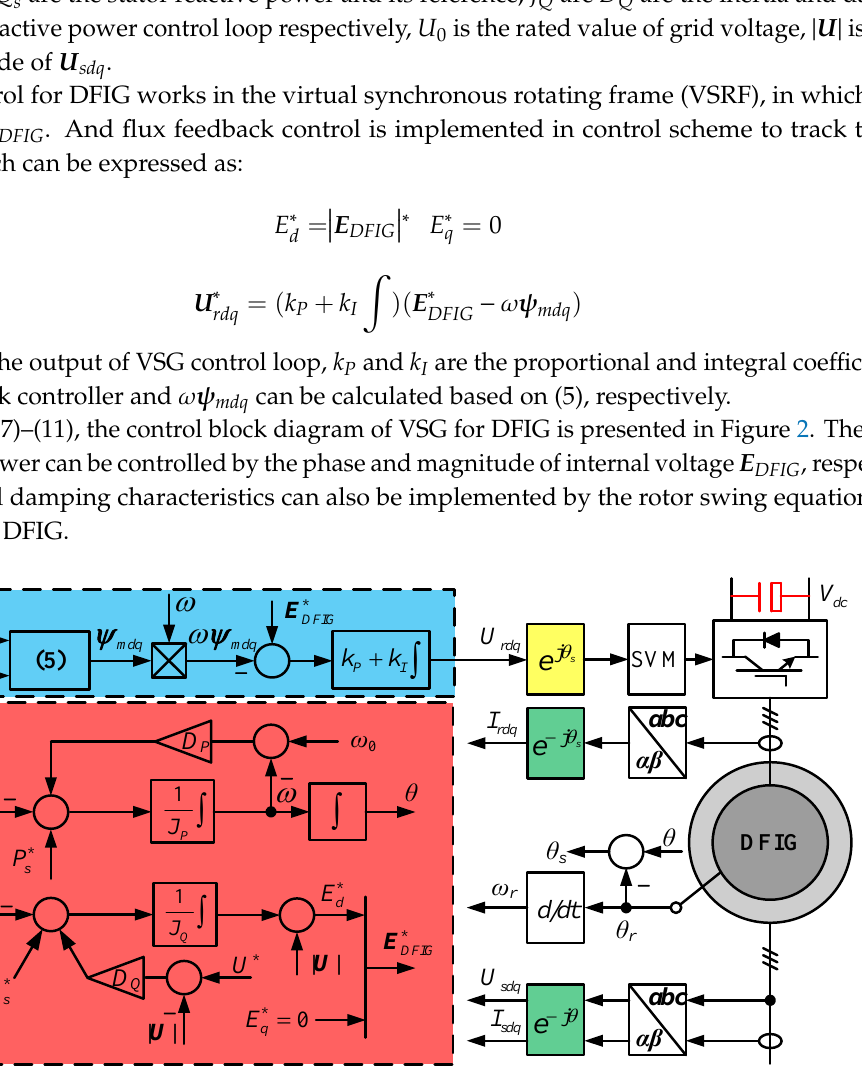
Figure 2. Control block diagram of virtual synchronous generator (VSG) for DFIG.